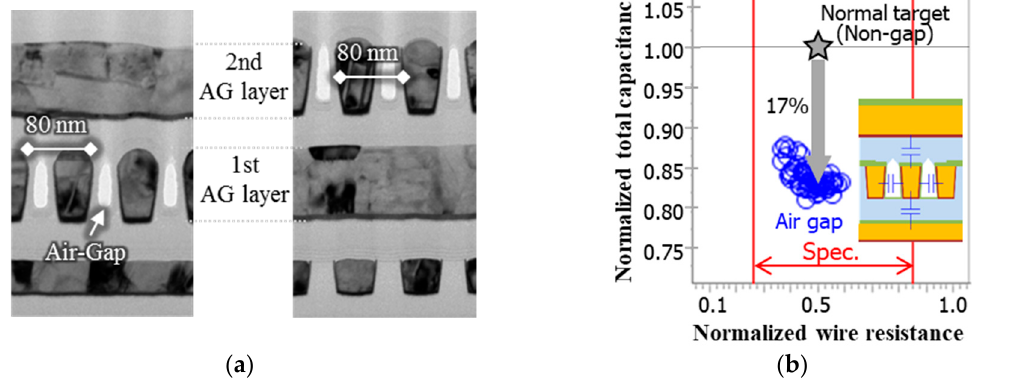
Figure 10. ( a ) Cross-sectional TEM images of consecutive AG layers and ( b ) RC plot of p80 wires with AG.